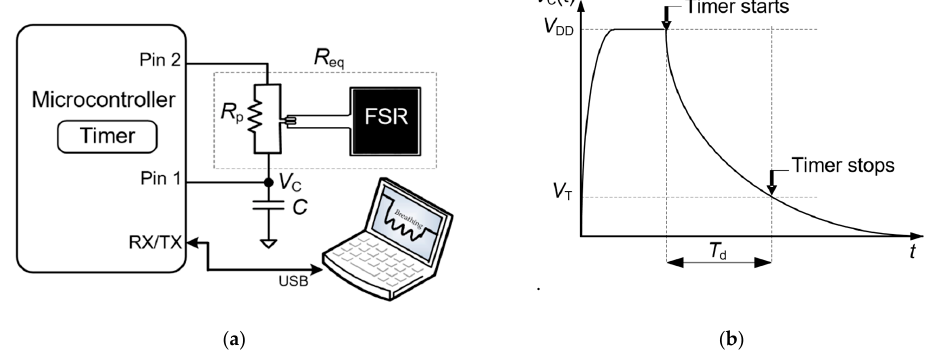
Figure 2. ( a ) DIC applied to measure the FSR so as to detect the occupancy of a seat; ( b ) waveform of the voltage across C during the measurement of the FSR.